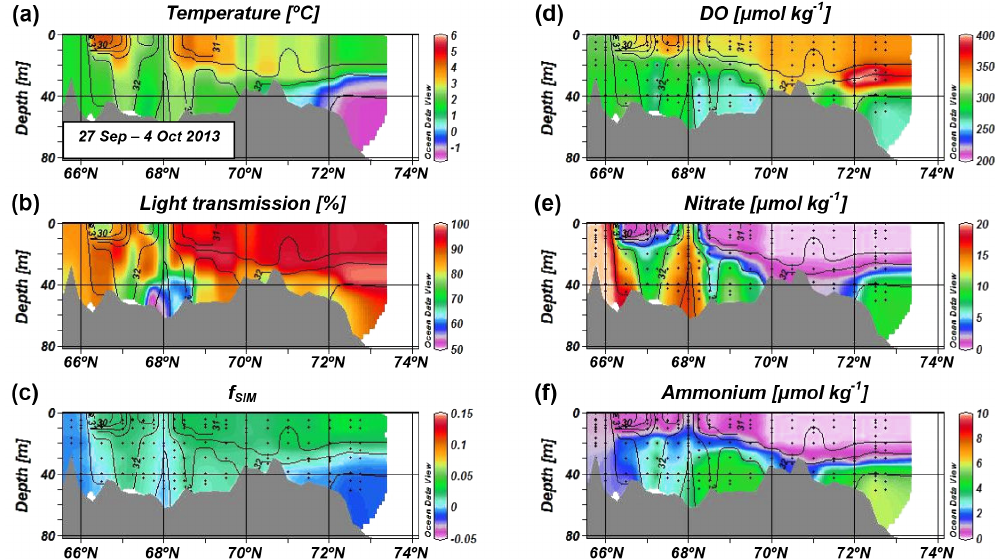
Figure 7. Vertical sections of (a) temperature ( ◦ C), (b) light transmission (%), (c) fraction of sea ice meltwater, (d) dissolved oxygen (µmolkg − 1 ) , (e) nitrate (µmolkg − 1 ) , and (f) ammonium (µmolkg − 1 ) along the 168 ◦ 45 (cid:48) W meridian near the US–Russia border obtained during the 27 September–4 October 2013 R/V Mirai cruise. The water sampling level at each station is indicated by a black dot. Salinity contours are superimposed on each section with a 0.5 contour